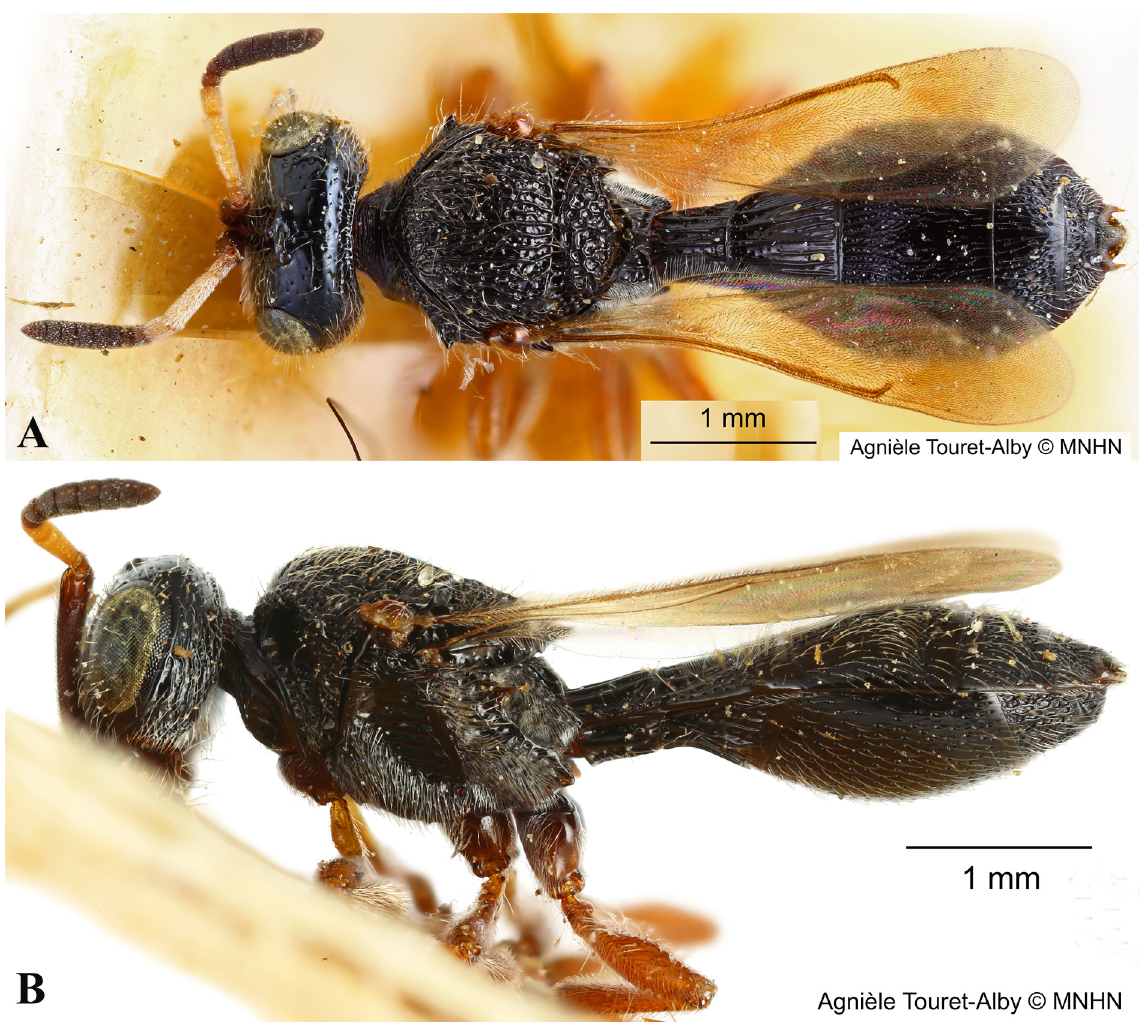
Fig. 5. Odontoscelio apperti (Risbec, 1953). Holotype, ♀ (MNHN EY25668). A . Habitus (dorsal